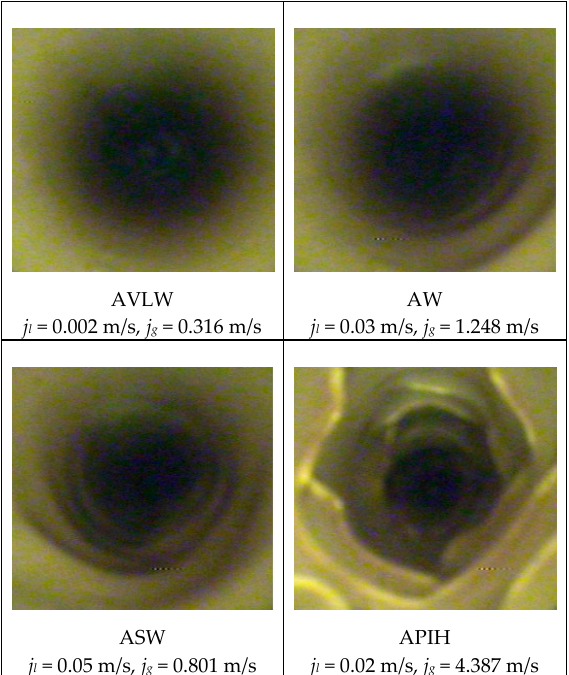
Figure 9. Influence of flow parameter on oil film undulation level with viscosity of 0.335 Pas in a pipe with diameter of 0.054 m.